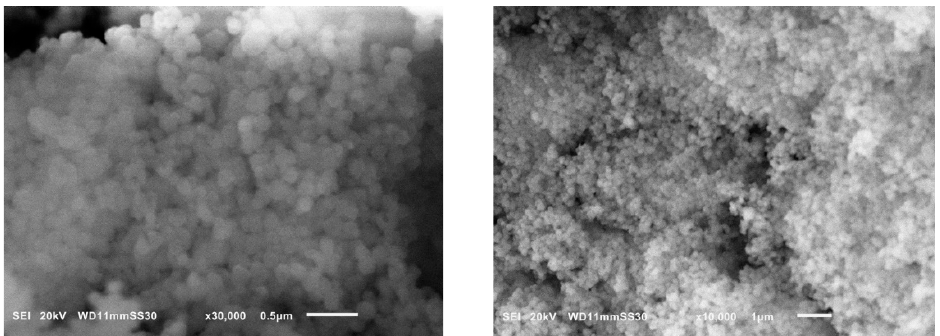
Figure 6. SEM images at different magnifications of the prepared Bio-MOF (MIP-202), synthesized at 110 ℃ for 18 h in pure water.